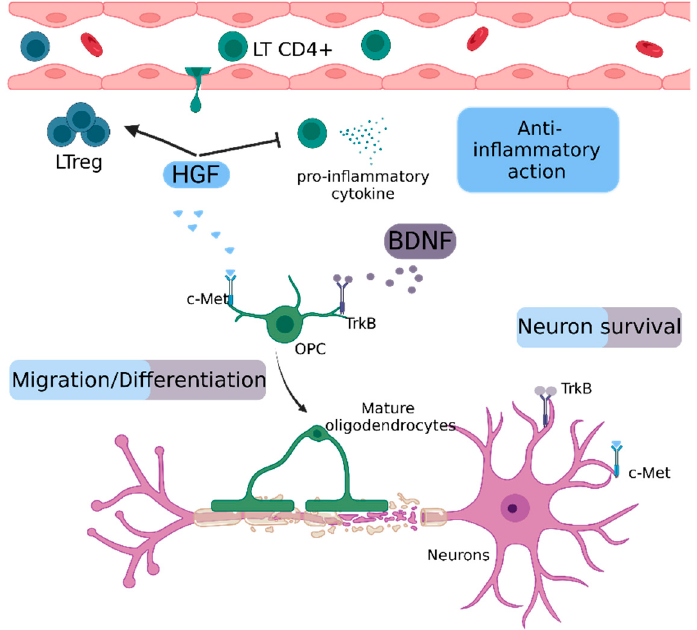
Figure 5. Schematic representation of repair mechanisms mediated by HGF and BDNF. BDNF: Brain-derived neurotrophic factor, c-Met: tyrosine protein kinase Met, HGF: Hepatocyte growth factor, OPC: oligodendrocyte precursor cell, LT CD4 + : CD4 T Lymphocyte, LTreg: regulatory T lymphocyte, TrkB: tropomyosin receptor kinase B.